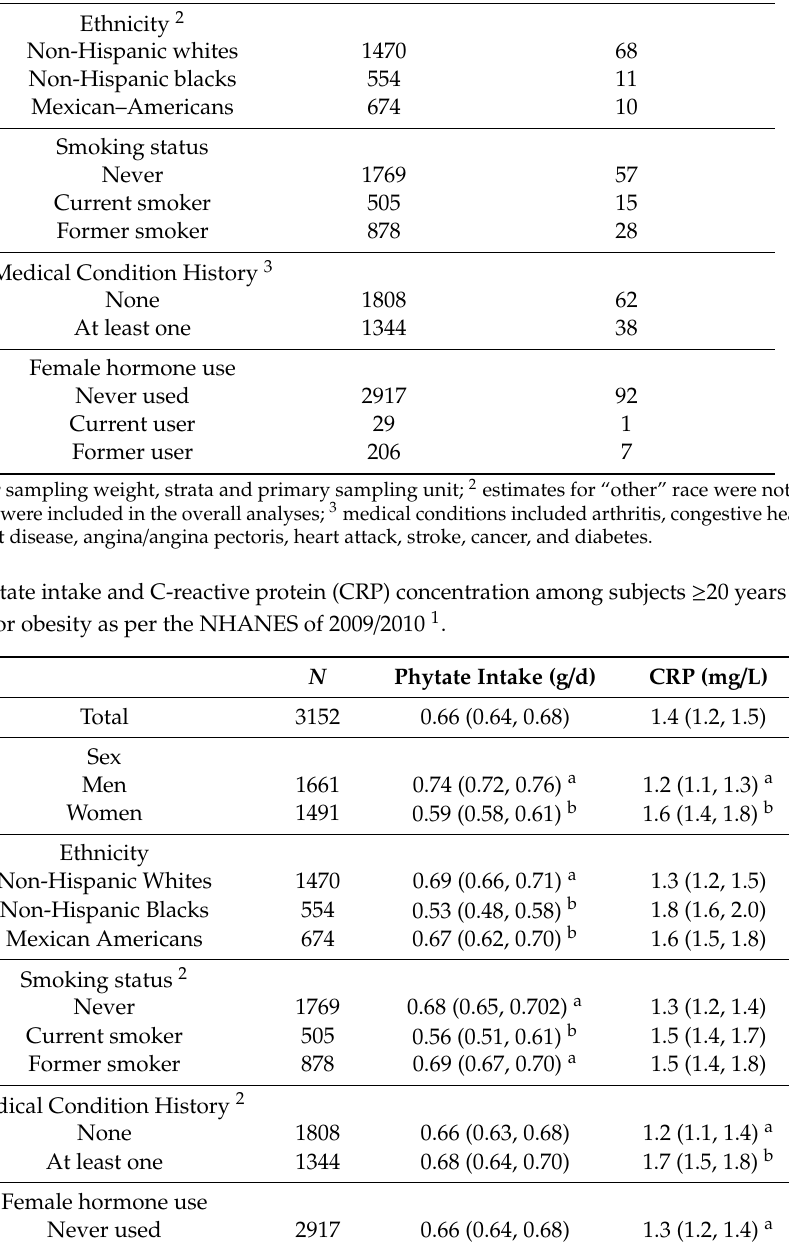
1 Values are medians with 95% CIs. Values with dissimilar alphabetical superscripts di ff er significantly ( p ≤ 0.05, Bonferroni correction); 2 Medical conditions included arthritis, congestive heart failure, coronary heart disease, angina / angina pectoris, heart attack, stroke, cancer, and